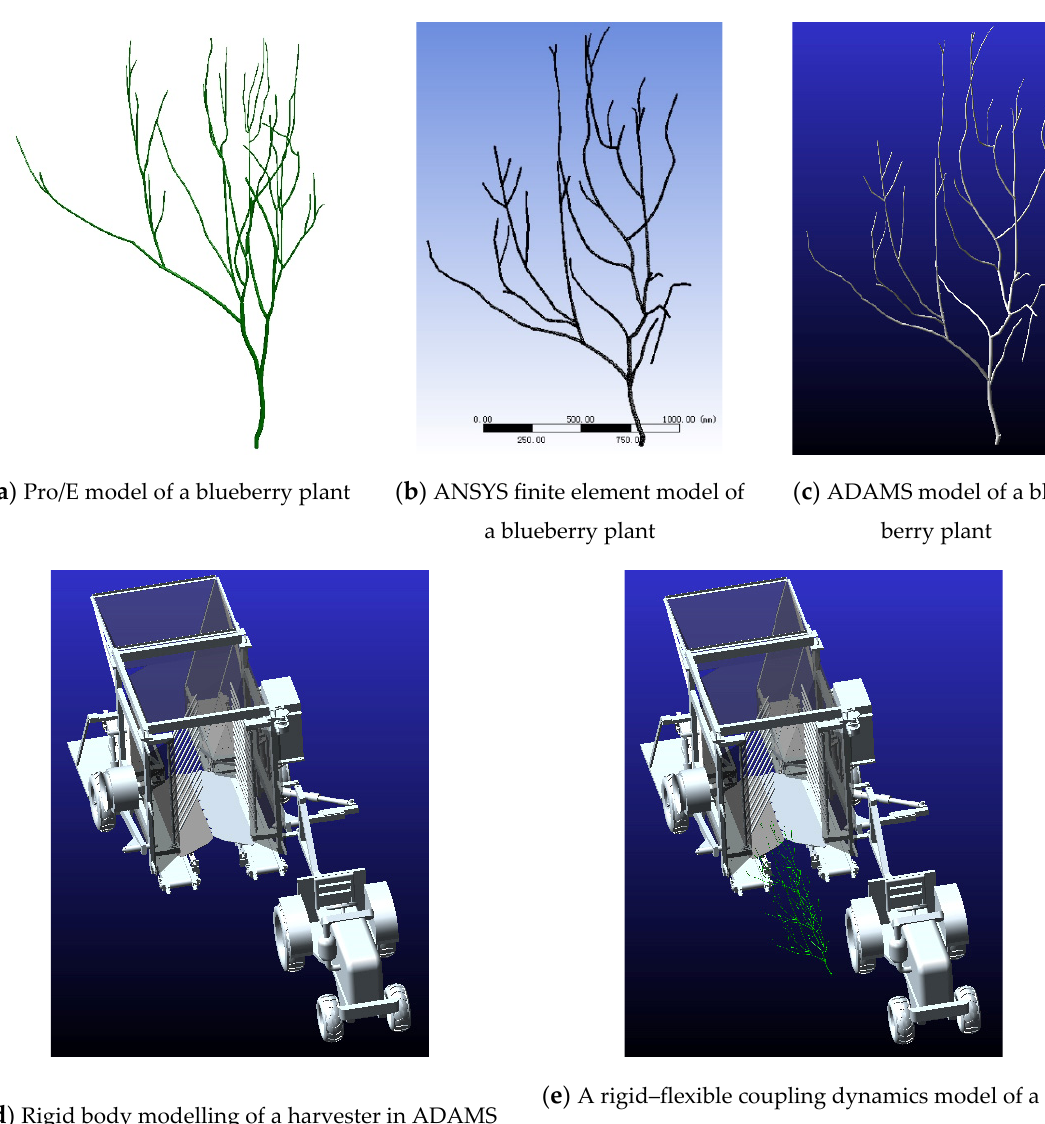
Figure 8. Modelling the rigid–flexible coupling collision harvesting process.